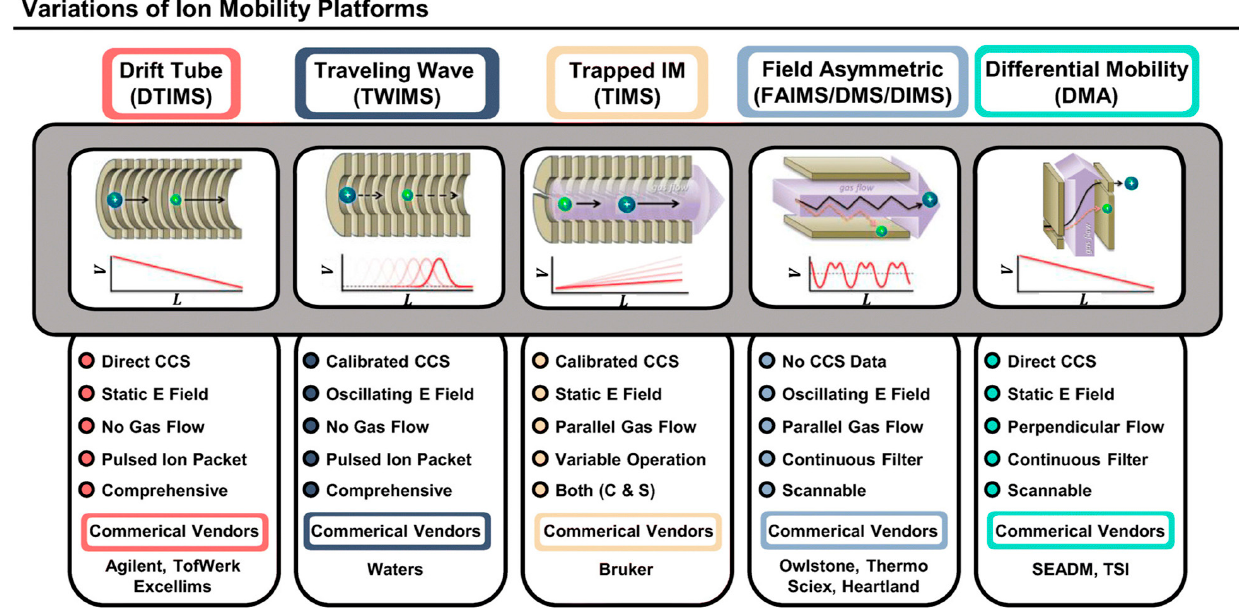
Figure 4. Schematic and features of different ion mobility platforms [18]. Adjusted and reprinted with permission from the American Chemical Society.